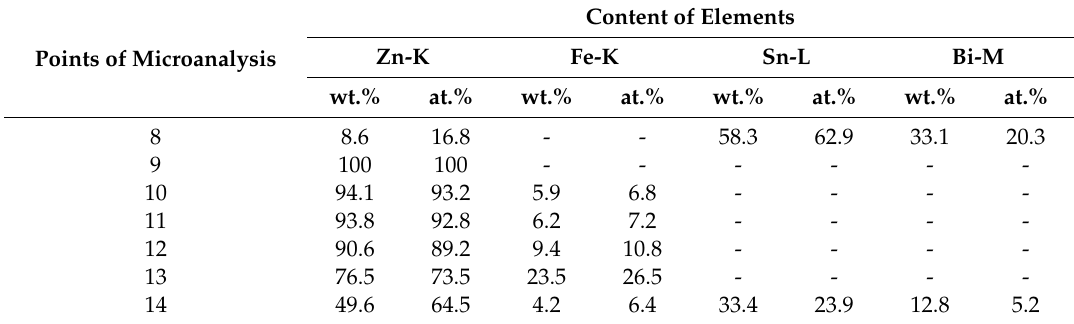
Table 3. The results of the microanalysis of the composition in marked points visible on Figure 5. Content of Elements Zn-K Fe-K Points of Microanalysis